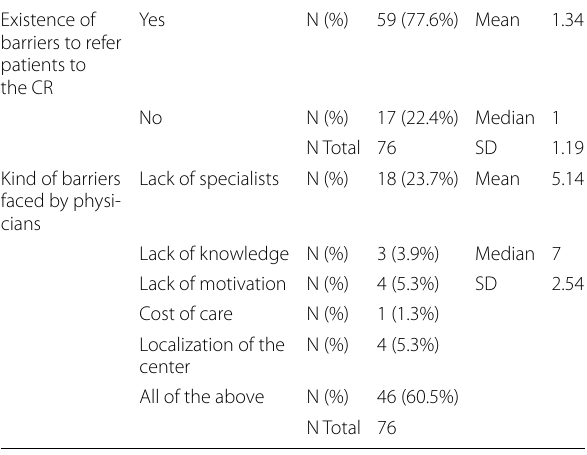
Table 5 Barriers to access cardiac rehabilitation (CR) according to the